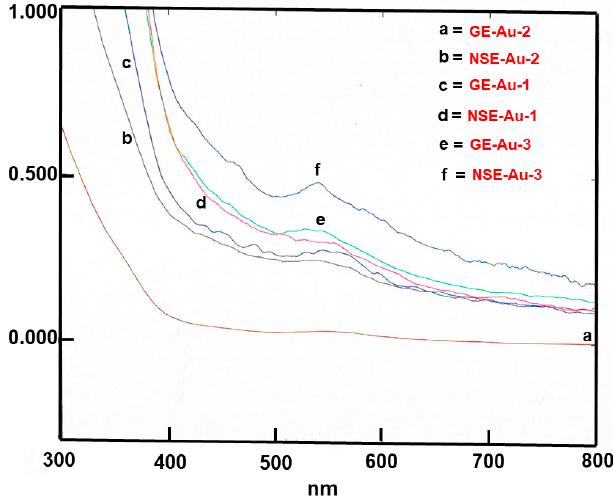
Figure 1. UV-Vis absorption spectra of gold nanoparticles prepared from both GE (5, 10, and 20 mL) and NSE (5, 10, 20 mL) at different concentrations of extracts.